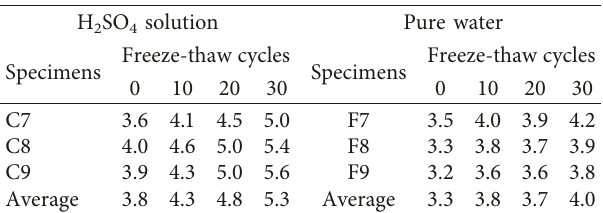
Figure 5: Curve of the changes of the mass of the rock specimens. Two different kinds of solution are labelled by ① H 2 SO 4 solution and ② pure water. Table 1: Result of the measurement of the porosity of the sand- stones (porosity (%)).